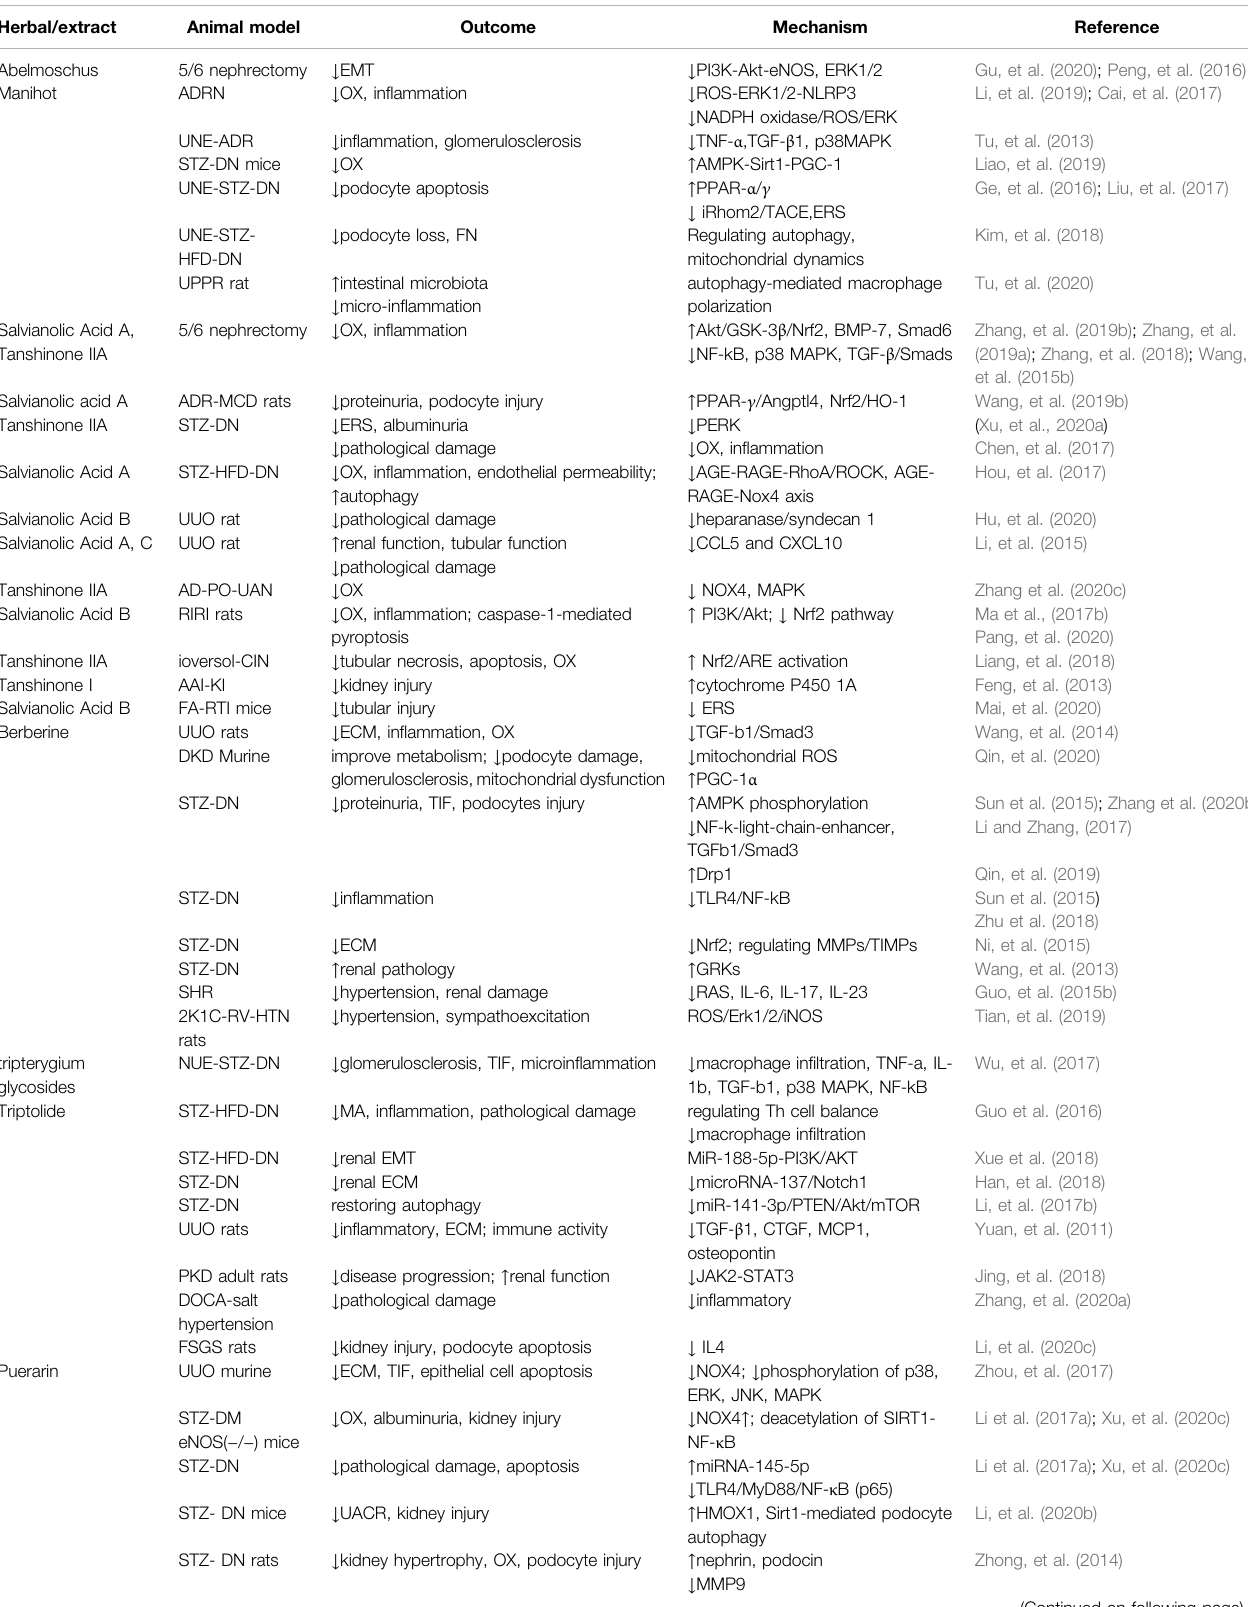
TABLE 1 | Recent animal studies on Chinese herbal medicines with anti-renal fi brosis function.